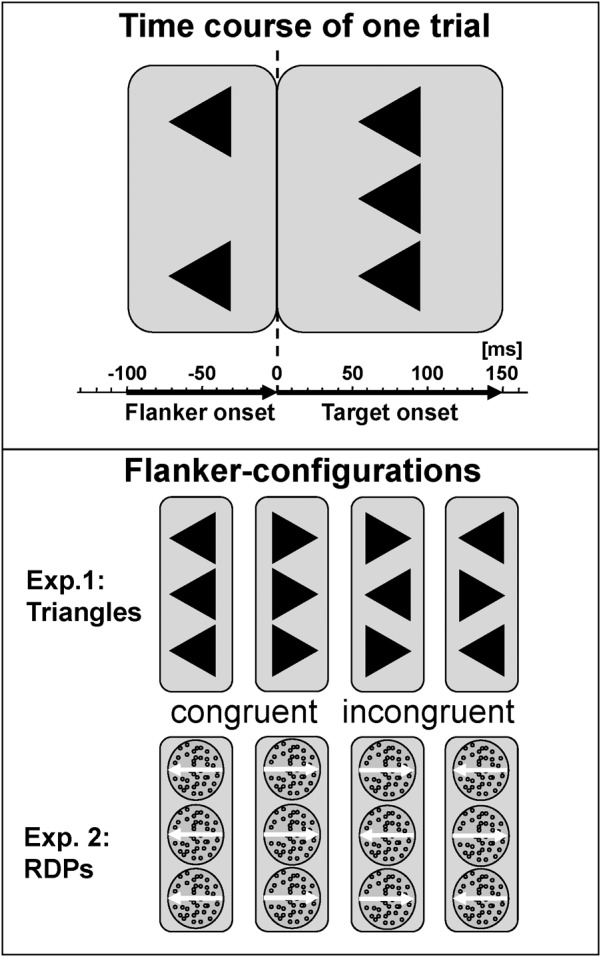
Task description. Flankers preceded presentation of the central target by 100 ms, which persists together with the flankers for a further 150 ms. Stimuli were static arrowheads or dynamic RDPs, conditions were congruent or incongruent, and responses were required to the left or right. Stimulus-onset asynchrony was 1650 ms, respectively. Bold lines indicate at least medium effects with at least p < 0.10.